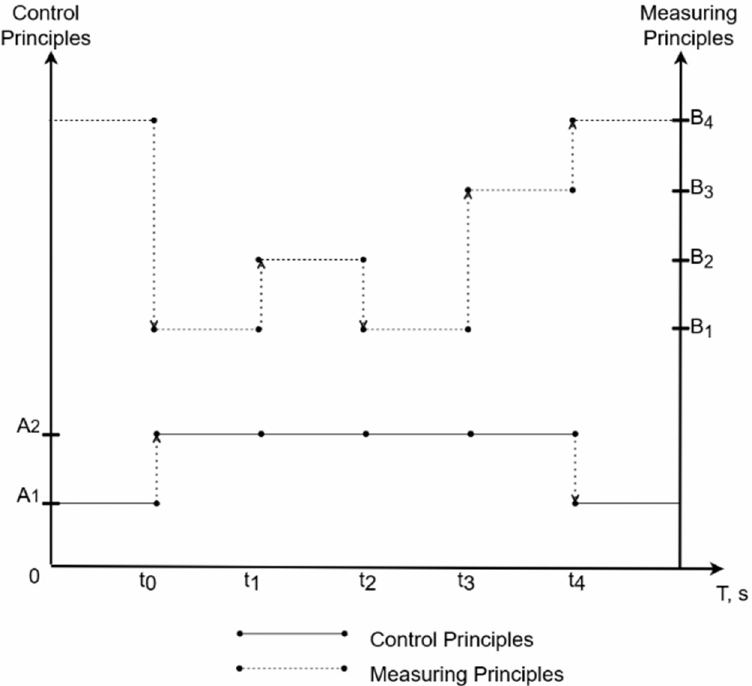
Figure 4. Scenario diagram of the proposed technology, where A1—intelligent control, A2—control according to classical algorithms, B1—direct measurements from pyrometers, B2—measurements corrected using ANN, B3—measurements predicted using ANN, and B4—measurements from pyrometers are absent.